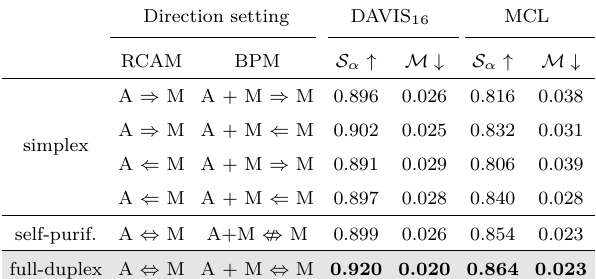
Table 6 Ablation study for the simplex and full-duplex strategies on DAVIS 16 [35] and MCL [85]. N = 4 for BPM Direction setting DAVIS